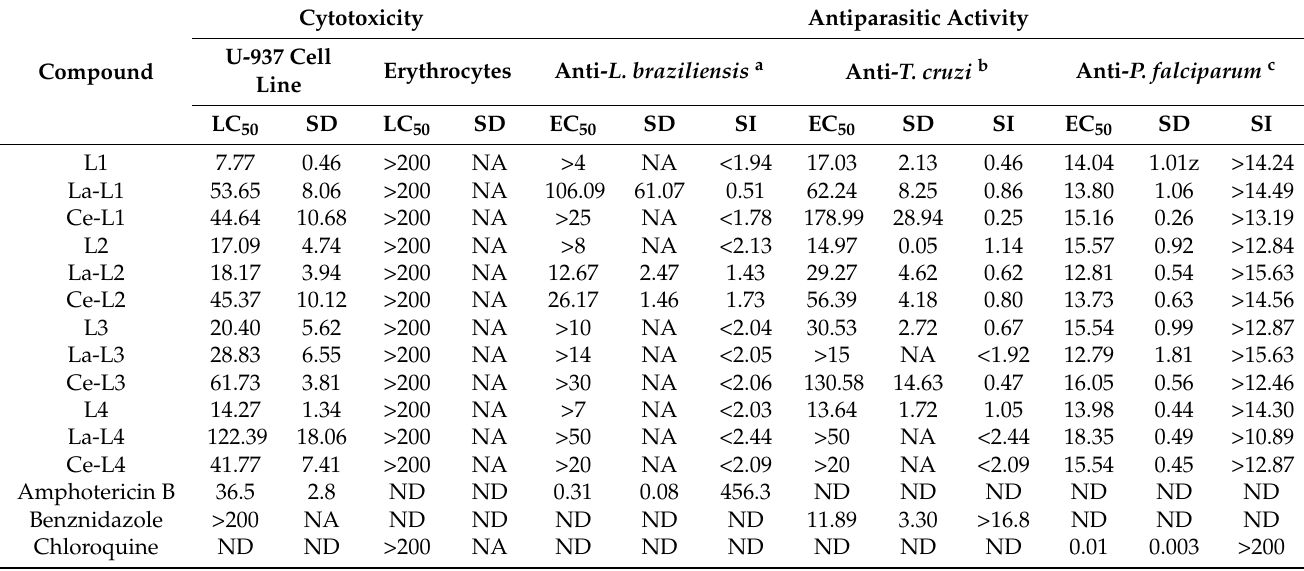
Table 1. In vitro antiparasitic and cytotoxic activities of Schiff bases and complexes